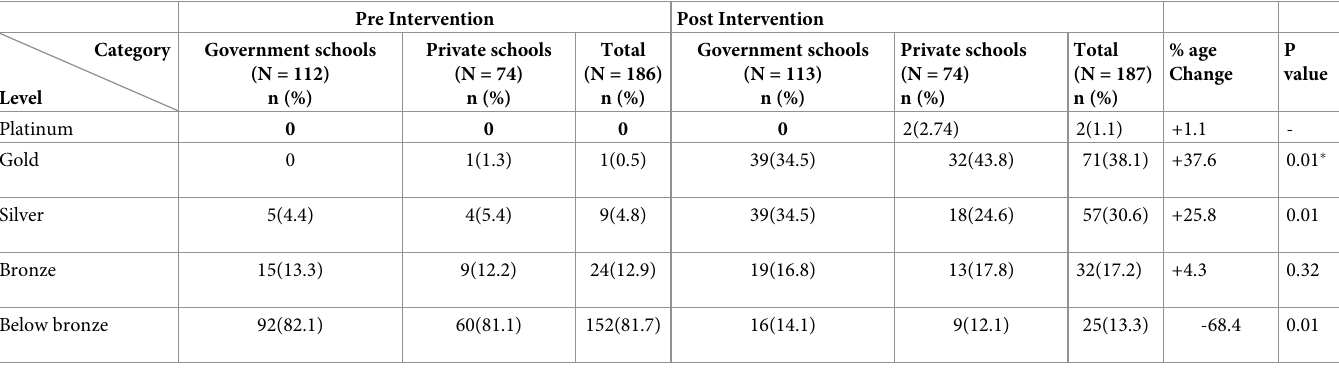
Table 2. Comparison of accreditation levels of Government and Private Schools in Chandigarh after one year of intervention (2016–2018). Pre Intervention Post Intervention